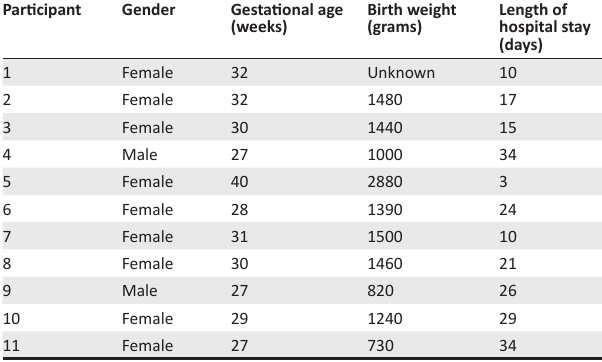
TABLE 2: Description of